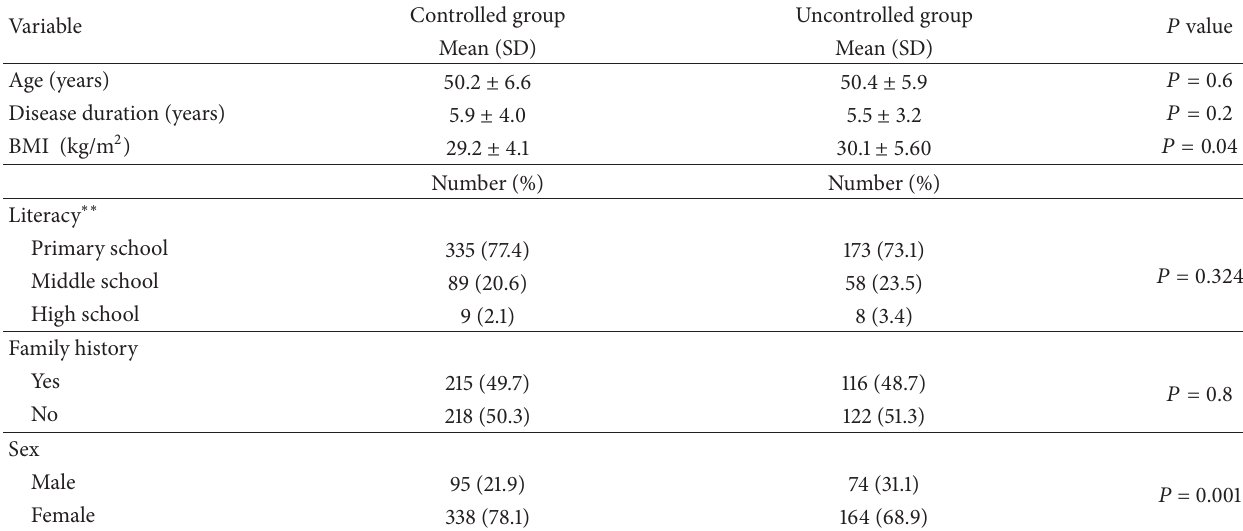
Table 1: Demographic characteristics of patients participating in the study in two controlled and uncontrolled groups.